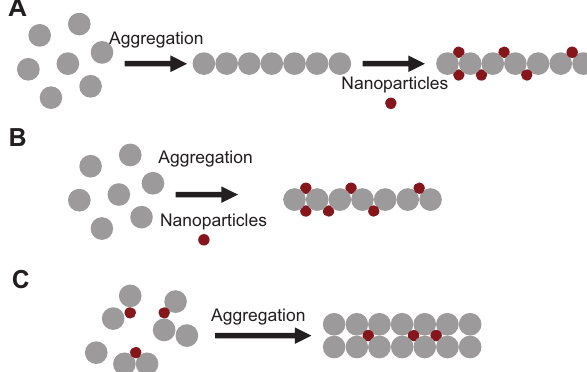
Figure 1 Schematic drawing of different methods for preparation of functionalized amyloid-like fibrils. (A) Amyloid-like fibrils are formed and then functionalized with nanoparticles. (B) Protein and nanoparticles are mixed and the protein aggregates in the presence of nanoparticles. (C) The protein and hydrophobic nanoparticles are mixed prior to dissolving the materials. Owing to the hydrophobic effect, the material stays together during protein aggregation and forms an amyloid-like material incorporating